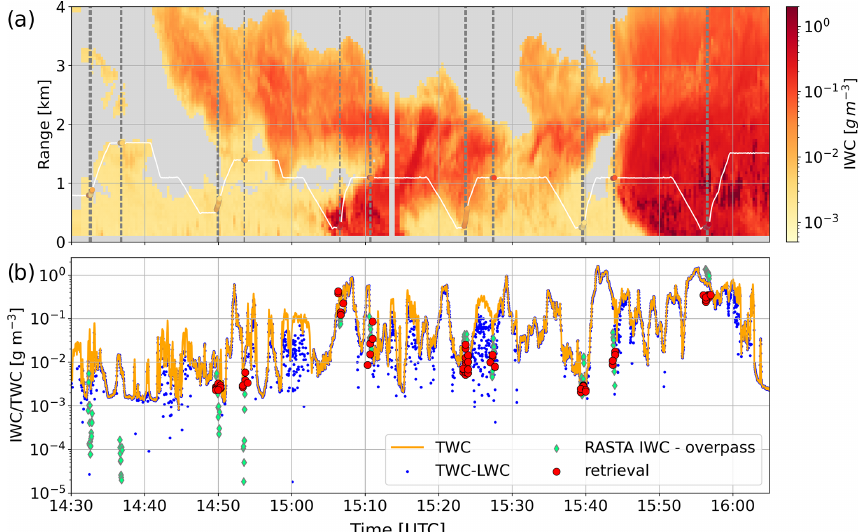
Figure 7. (a) Time–height plot of IWC retrieval, to which the aircraft trajectory is overlaid as altitude as a function of time; aircraft IWC values at time steps of aircraft overpasses (horizontal distance smaller than 1km) are shown as scattered points. Dashed vertical lines indicate when the aircraft is within 500m of horizontal distance to the radars. (b) Time series of water content measured by the aircraft (TWC and TWC − LWC) and overlaid radar